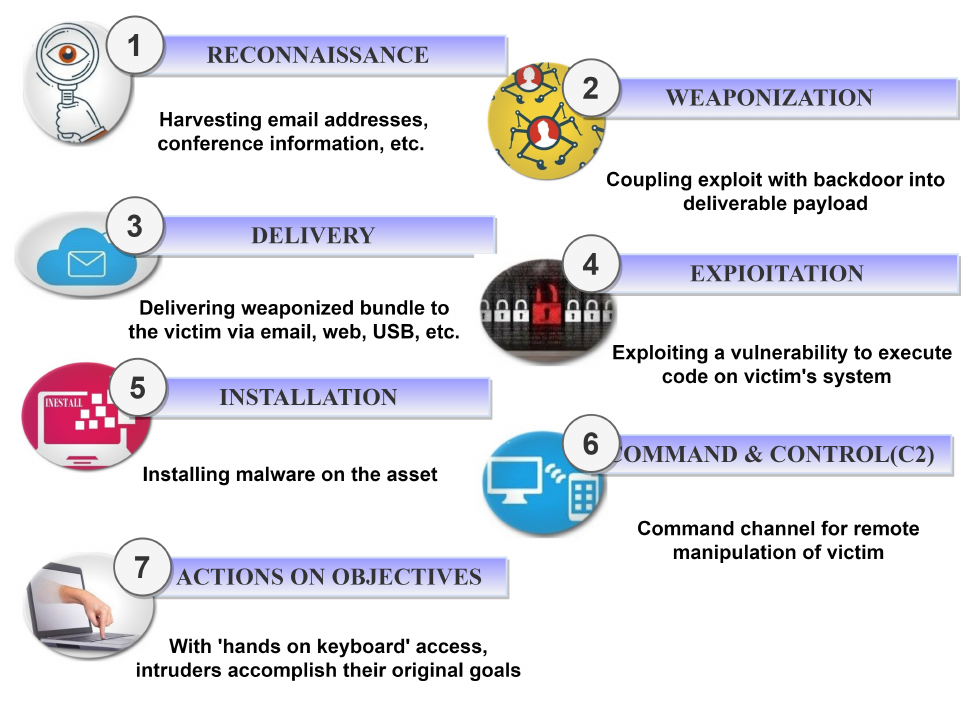
Figure 3. The stages of a typical cyber-attack according to CKC (Courtsey